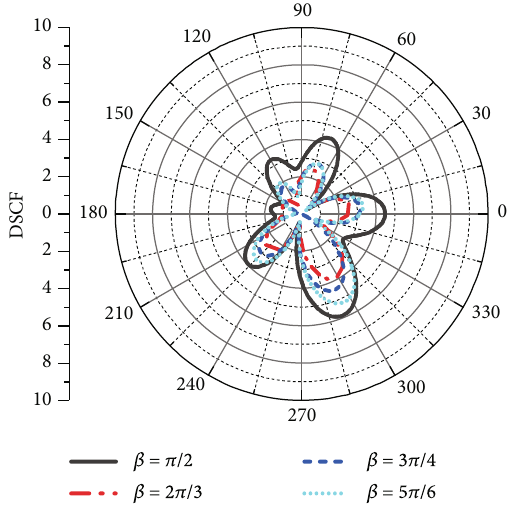
Figure 8: DSCF distribution of the circular hole for di ff erent values of β ( α 0 = 90 ° ).